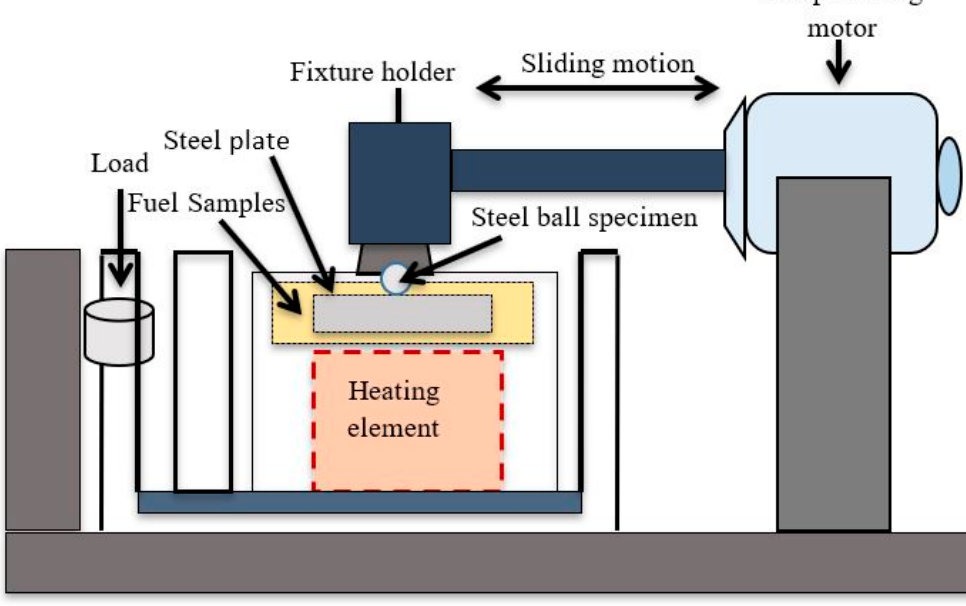
Figure 3. Schematic view of HFRR test rig.